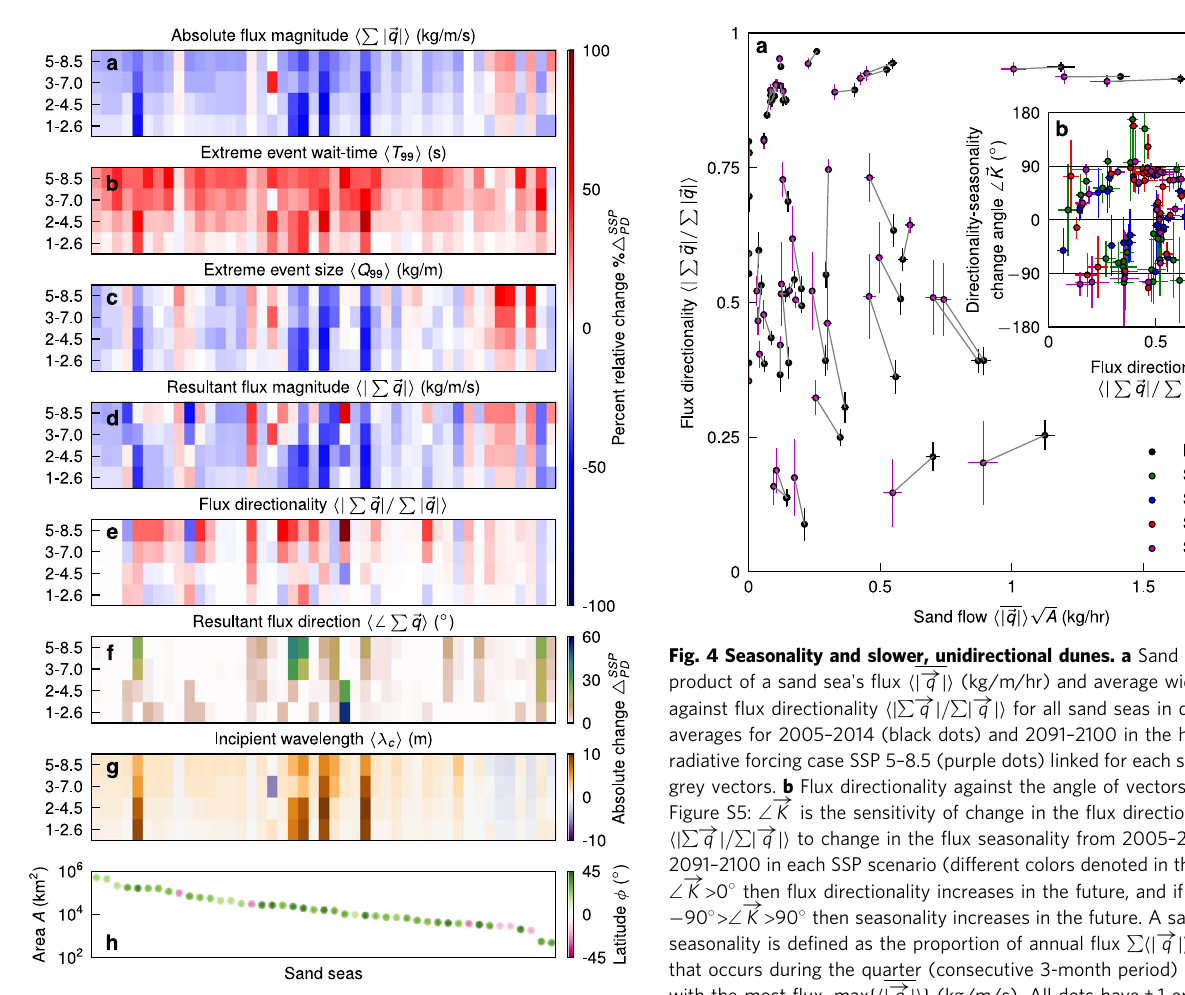
Fig. 3 Changes in key variables for dune morphology. Given for each sand sea in descending-area order (horizontally) from the present-day decade 2005 – 2014 to future decade 2091 – 2100 for each SSP scenario in ascending-radiative forcing order (vertically) are; percentage relative changes % Δ SSP PD for ( a ) total sand fl ux magnitude ∑ j q ! j (kg/m/s), 99th percentile event ( b ) wait-time T 99 (s) and ( c ) size Q 99 (kg/m), ( d ) resultant sand fl ux magnitude j ∑ q ! j (kg/m/s), ( e ) fl ux directionality j ∑ q ! j = ∑ j q ! j , and absolute changes Δ SSP PD in ( f ) resultant fl ux direction ff ∑ q ! ( ∘ ) and ( g ) incipient dune wavelength λ c (m). ( h ) Sand-sea area A (km 2 ) colored by centroid latitude ϕ ( ∘ ).